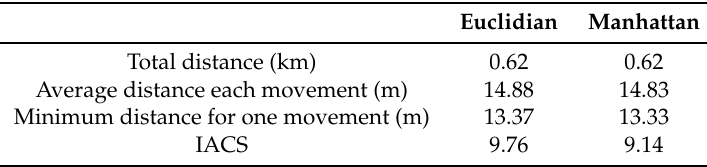
Table 2. Heuristic